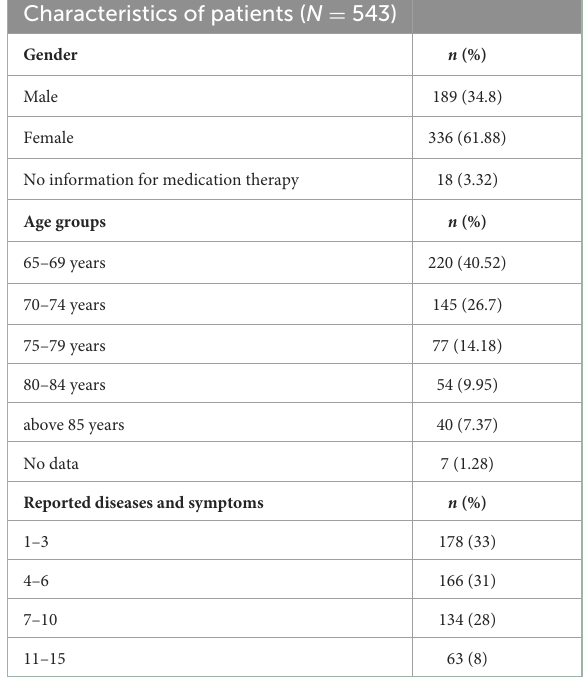
TABLE 1 Demographic characteristic of study